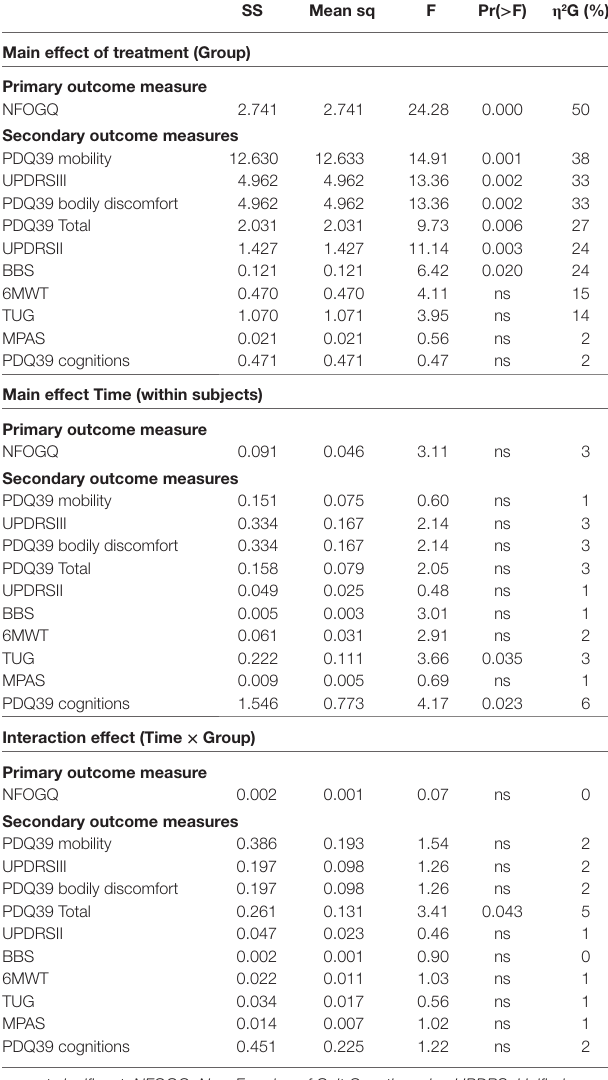
TablE 3 | Split plot ANOVA